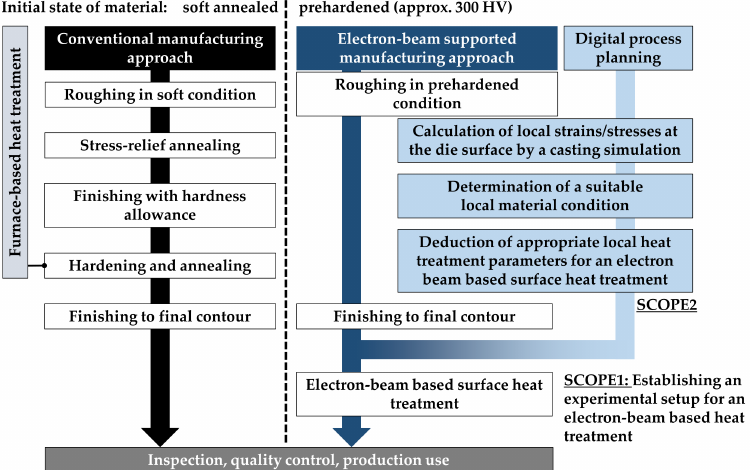
Figure 2. Manufacturing concept of an electron-beam supported heat treatment compared to a conventional, furnace-based heat treatment; designation of Scope 1 and 2 considered within the framework of this